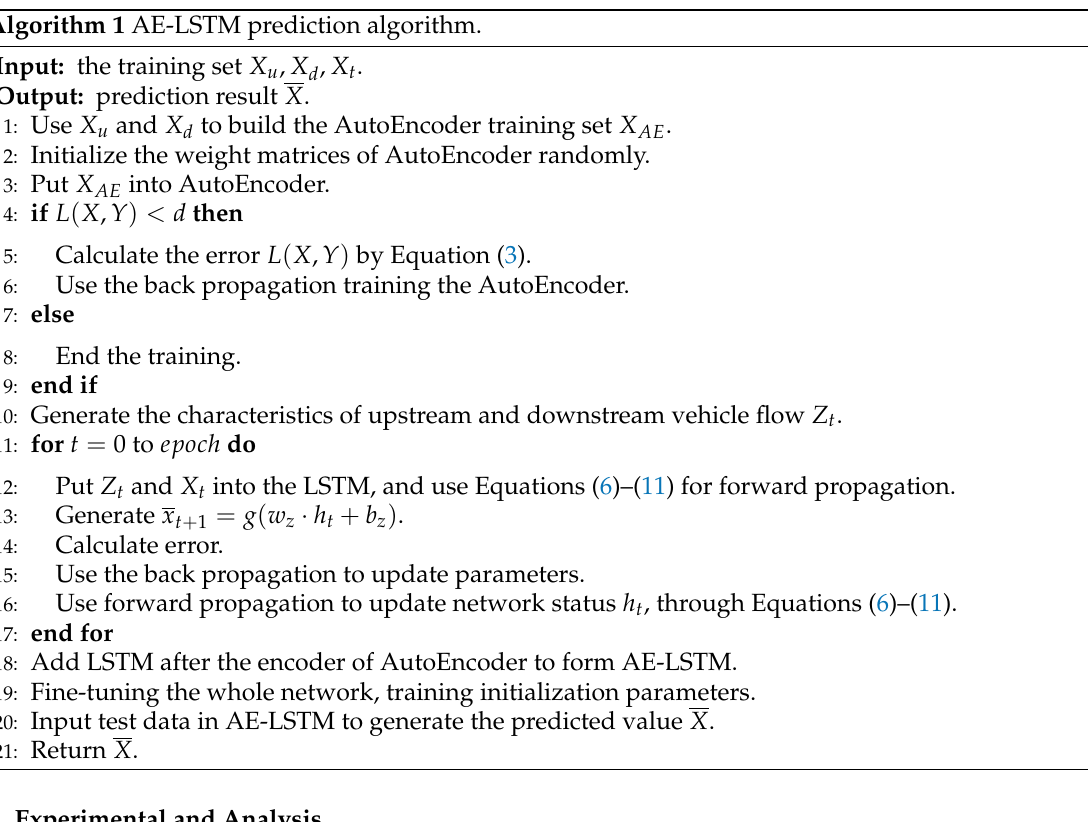
Algorithm 1 AE-LSTM prediction